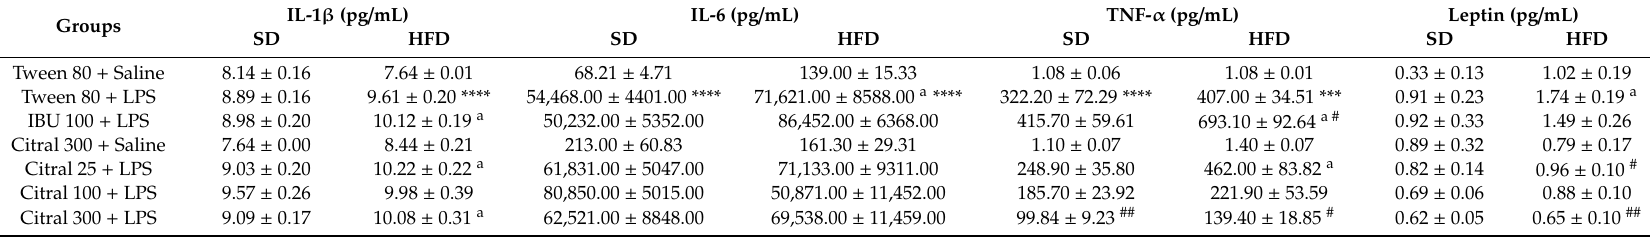
Table 5. Citral’s e ff ect on the serum levels of cytokines (IL-1 β , IL-6 and TNF- α ) and leptin in animals fed with standard diet (SD) or high-fat diet (HFD) after 90 min of the